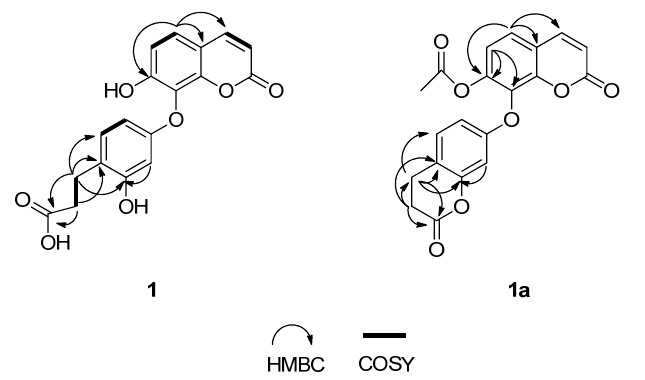
Figure 2. Key HMBC and 1 H- 1 H COSY correlations of 1 and 1a